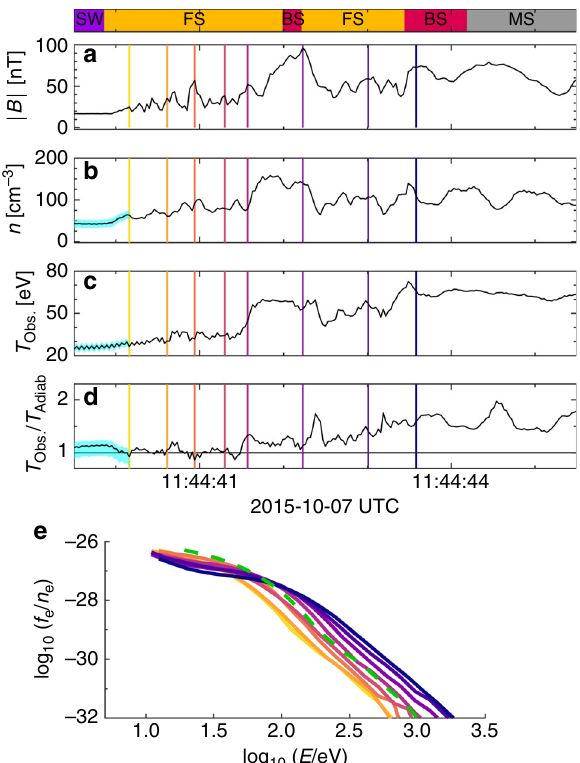
Fig. 2 MMS data for bow shock crossing. a Plot of the average magnetic fi eld from MMS1 as a function of time. The bar on the top of the plots denotes the part of the shock that the spacecraft is observing. The spacecraft is initially in the solar wind (SW) approaching the Earth's bow shock, then travels through the foreshock (FS) and the bow shock (BS) before entering the Earth's magnetosheath (MS). The part of the plot highlighted in light blue denotes the low density of the solar wind. This low density affects spacecraft performance, leading to uncertainty in the measurement of T Obs. / T Adiab. in this region. b Plot of the density from MMS1 as a function of time. c Plot of the observed temperature ( T Obs. = Tr ( P )/(3 n )) from MMS1 as a function of time. d Plot of the observed temperature as compared to the temperature expected from compressional heating alone ( T Adiab. = n 2/3 ). e Pitch-angle-averaged distributions at the times denoted by the colored lines in a – d . The green dashed line denotes what the fi nal distribution at the last point should look like if it only underwent compressional heating from the initial yellow time point to the fi nal blue time point. All of these time points are chosen to be near peaks of the magnetic fl uctuations spaced upstream of this quasi-perpendicular shock front, θ Bn = 83 ∘ , at Alfv ́ nic Mach number, M A = 6.3 27